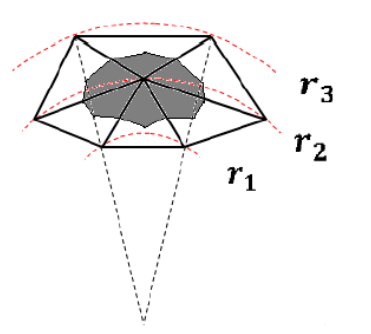
Fig. 2 Division of the control body in the